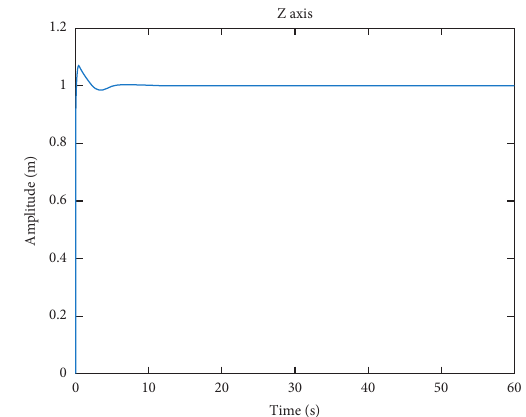
Figure 3: PID Angular Response of SIL simulation.